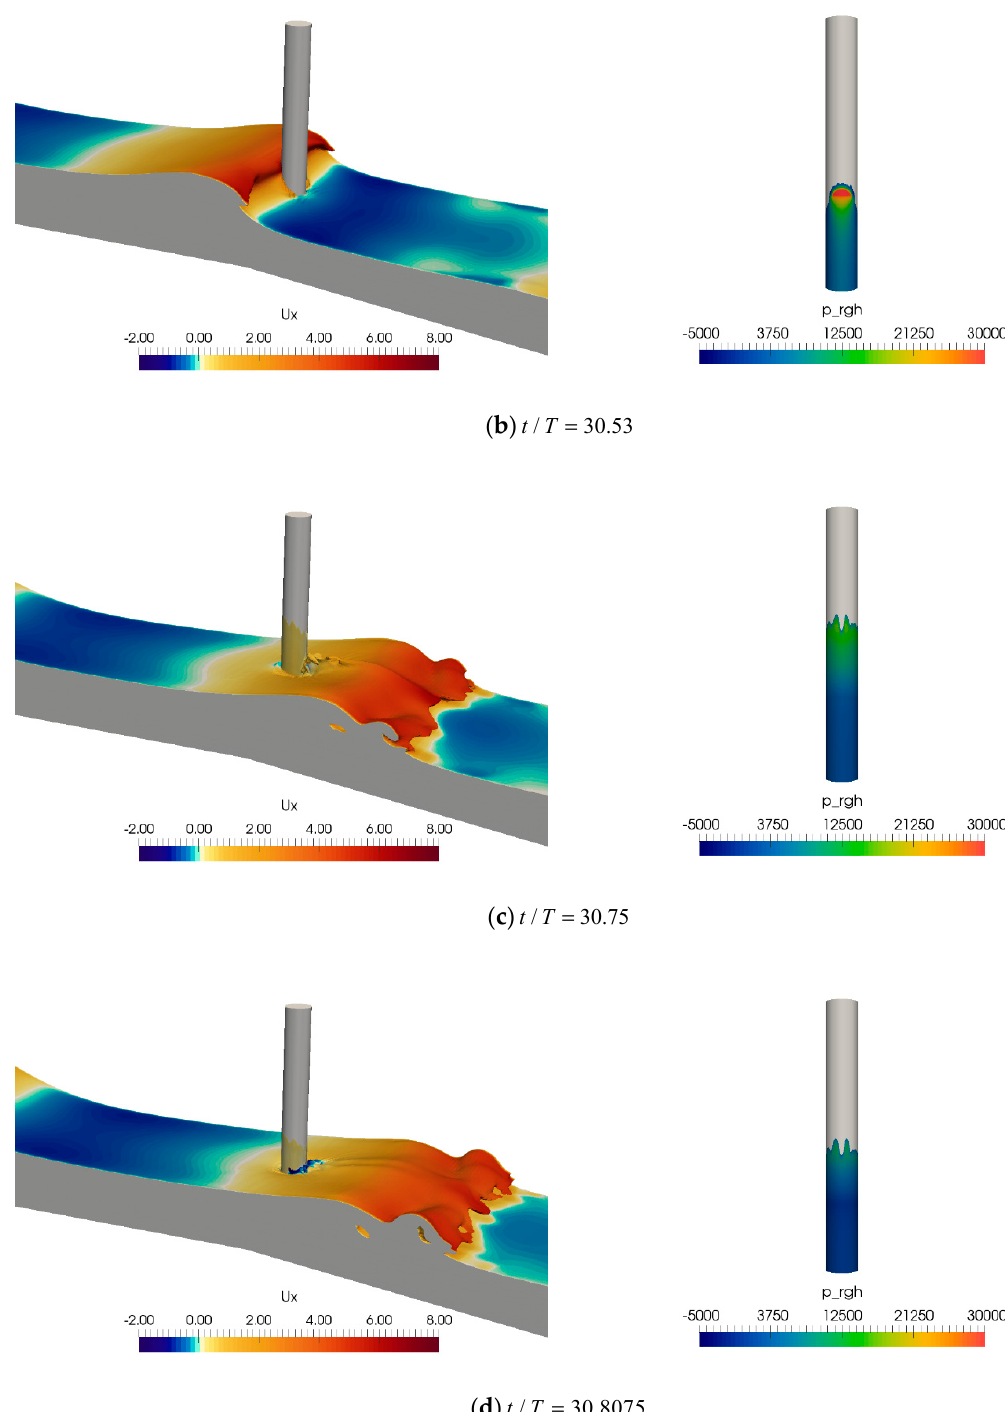
Figure 15. Free surface elevations around the vertical cylinder with horizontal velocity contours (left). Dynamic pressure on the cylinder from the wave propagation view (right): ( a ) t / T = 30.275, ( b ) t / T = 30.53, ( c ) t / T = 30.75, and ( d ) t / T =